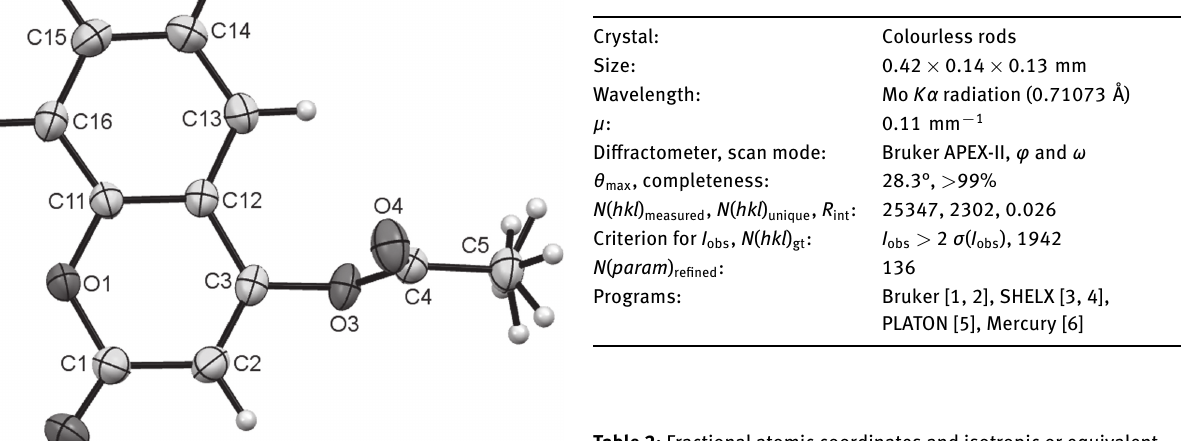
Table 2: Fractional atomic coordinates and isotropic or equivalent isotropic displacement parameters (Å 2